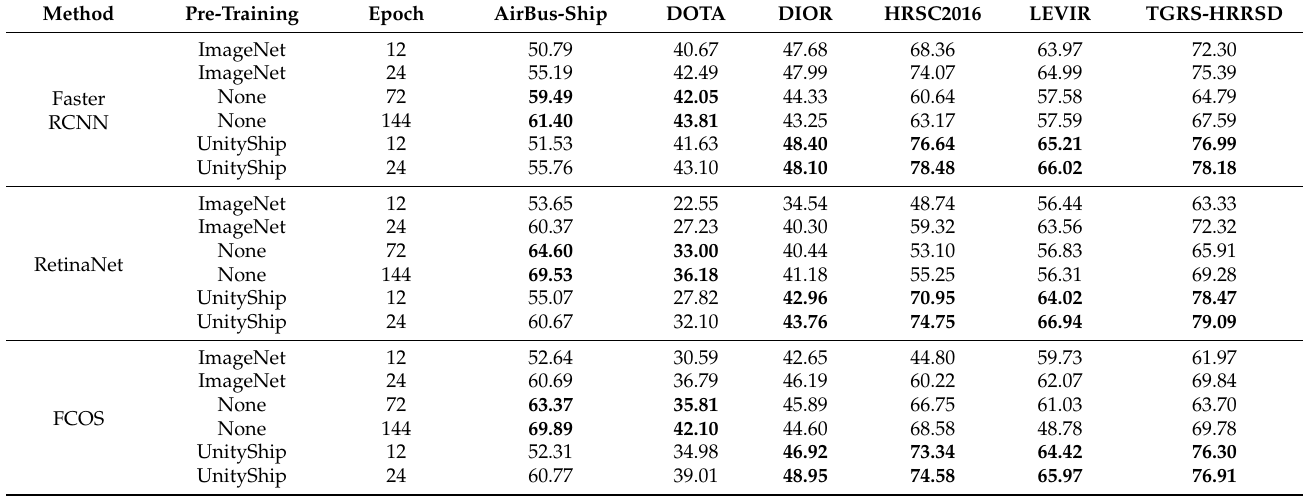
Table 4. Comparison of AP for different datasets with different pre-training and training schedules. The red indicates results for longer training schedules (24 and 144 epochs) and the green indicates results for shorter training schedules (12 and 72